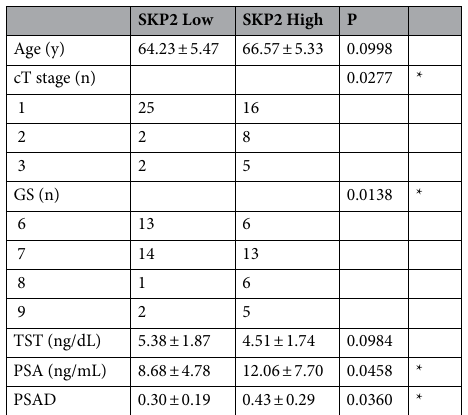
Table 4. Comparison of clinical factors between SKP2 Low and SKP2 High groups. Data are expressed as means ± standard deviation unless otherwise indicated. cT stage = clinical tumour stage, GS = Gleason score, TST = testosterone, PSA = prostate-specific antigen, PSAD = PSA density. *Statistical significance ( p < 0.05).